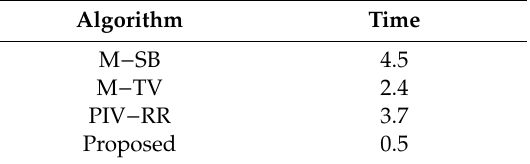
Table 8. Comparison of algorithm running time (min).